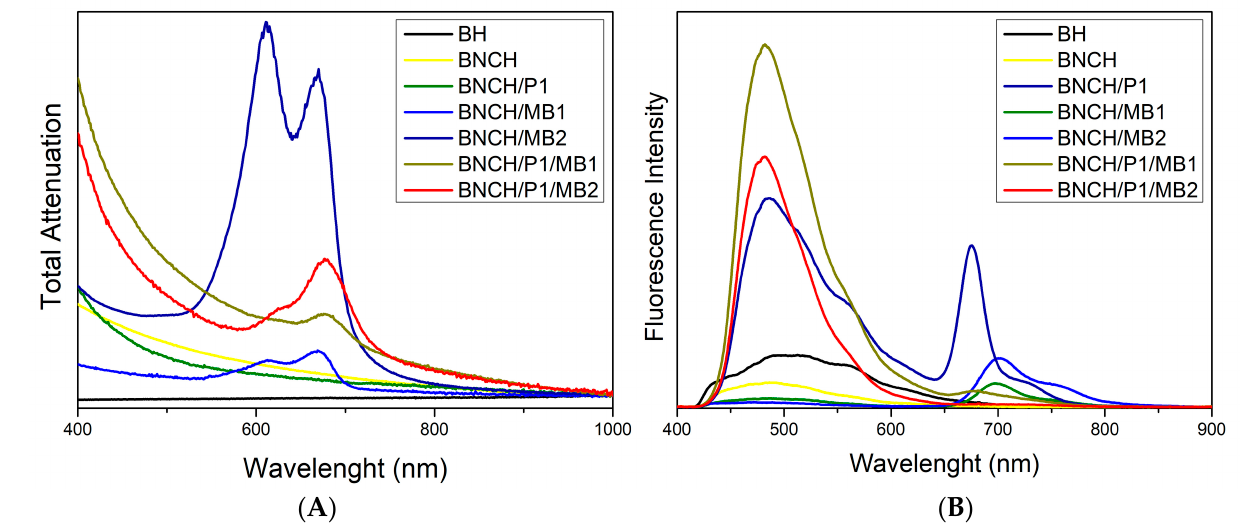
Figure 5. ( A ) UV-Vis and ( B ) fluorescence emission spectra of the hydrogels. BNC hydrogels containing MB present two main absorption bands, with maxima centered around 670 nm and 610 nm, with the highest and the lowest intensities, respec- tively, in the less concentrated formulation (BNCH/MB1). However, in the most concen- trated formulation (BNCH/MB2), these bands have their intensities inverted, suggesting an MB dimerization process (Figure 6). According to the literature, MB is in balance be- tween its monomeric and dimeric forms, which have maximum absorbance around 660 nm and 610 nm, respectively, similar to our results. At higher concentrations of MB, there is a tendency for dye aggregation, generating an equilibrium shift for the formation of dimers and band inversion [50]. In formulations containing MB and EPP-AF ® , it is possible to observe a slight shift of the bands from 670 and 610 nm to 680 and 620 nm, respectively, probably caused by the interaction between MB and propolis.